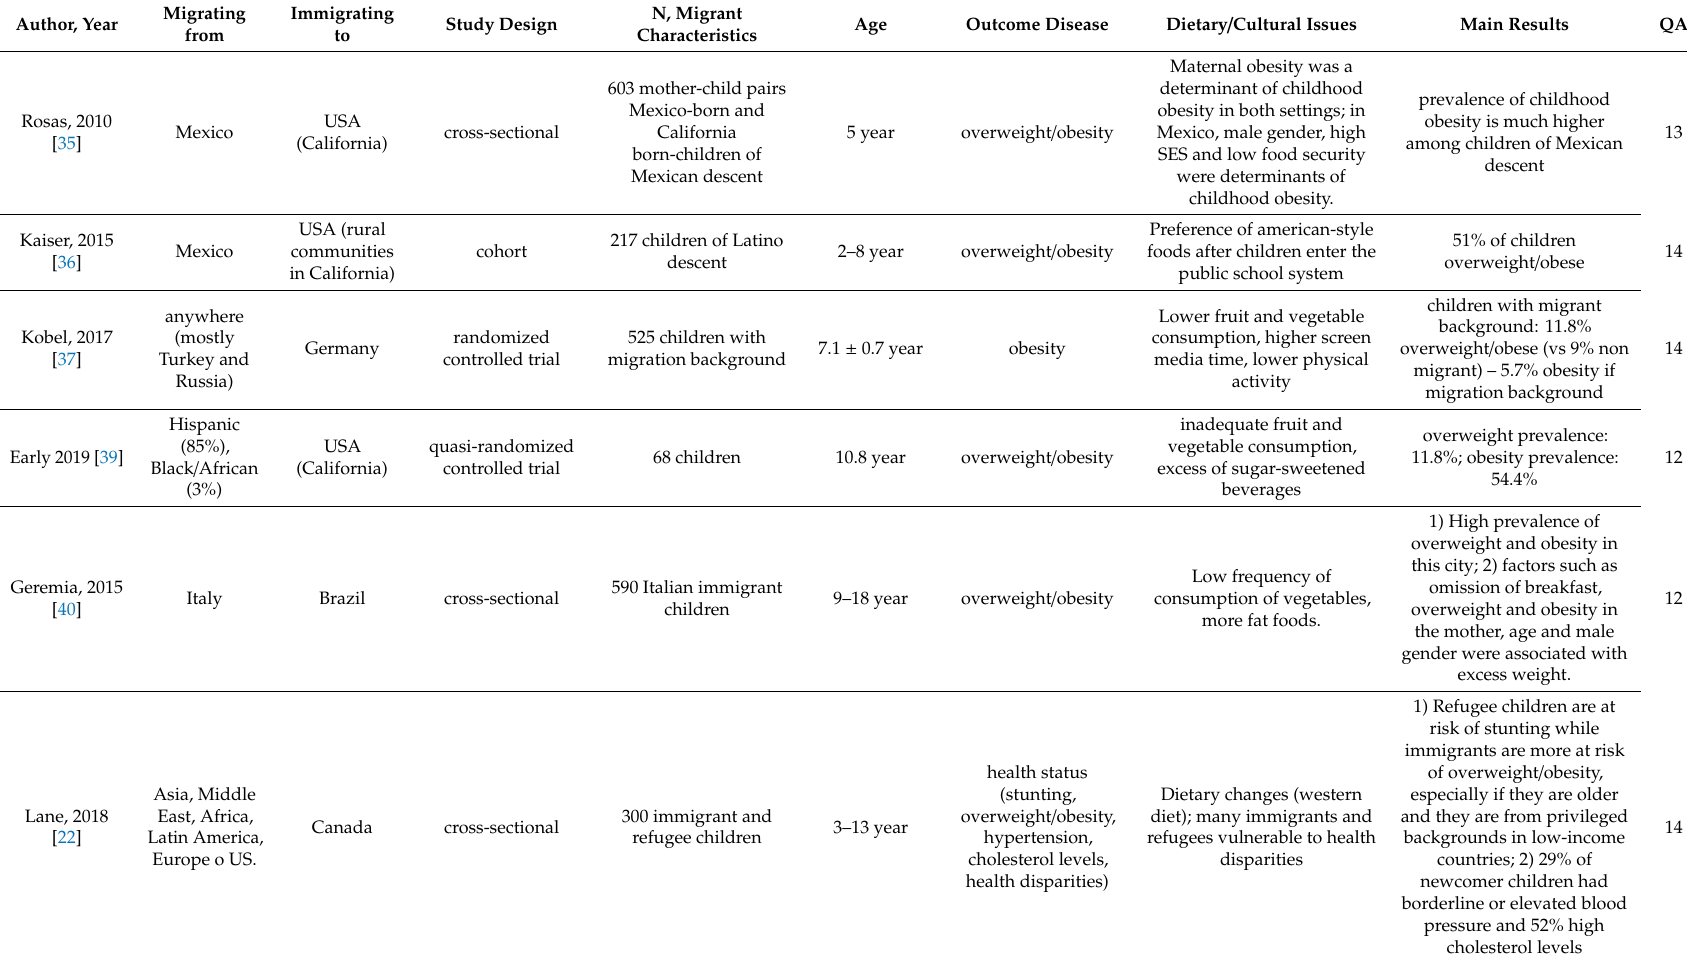
Table 1. Characteristics and main results of the included studies.